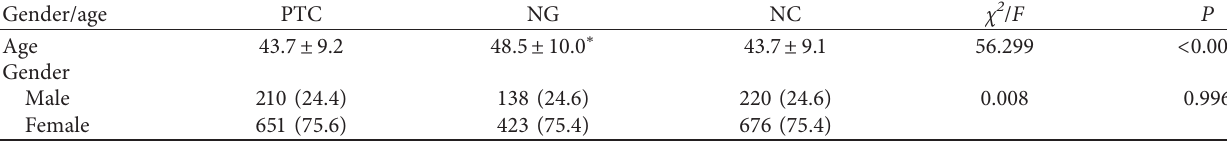
Table 1: The age and gender distribution between PTCs, NGs, and NCs [ n